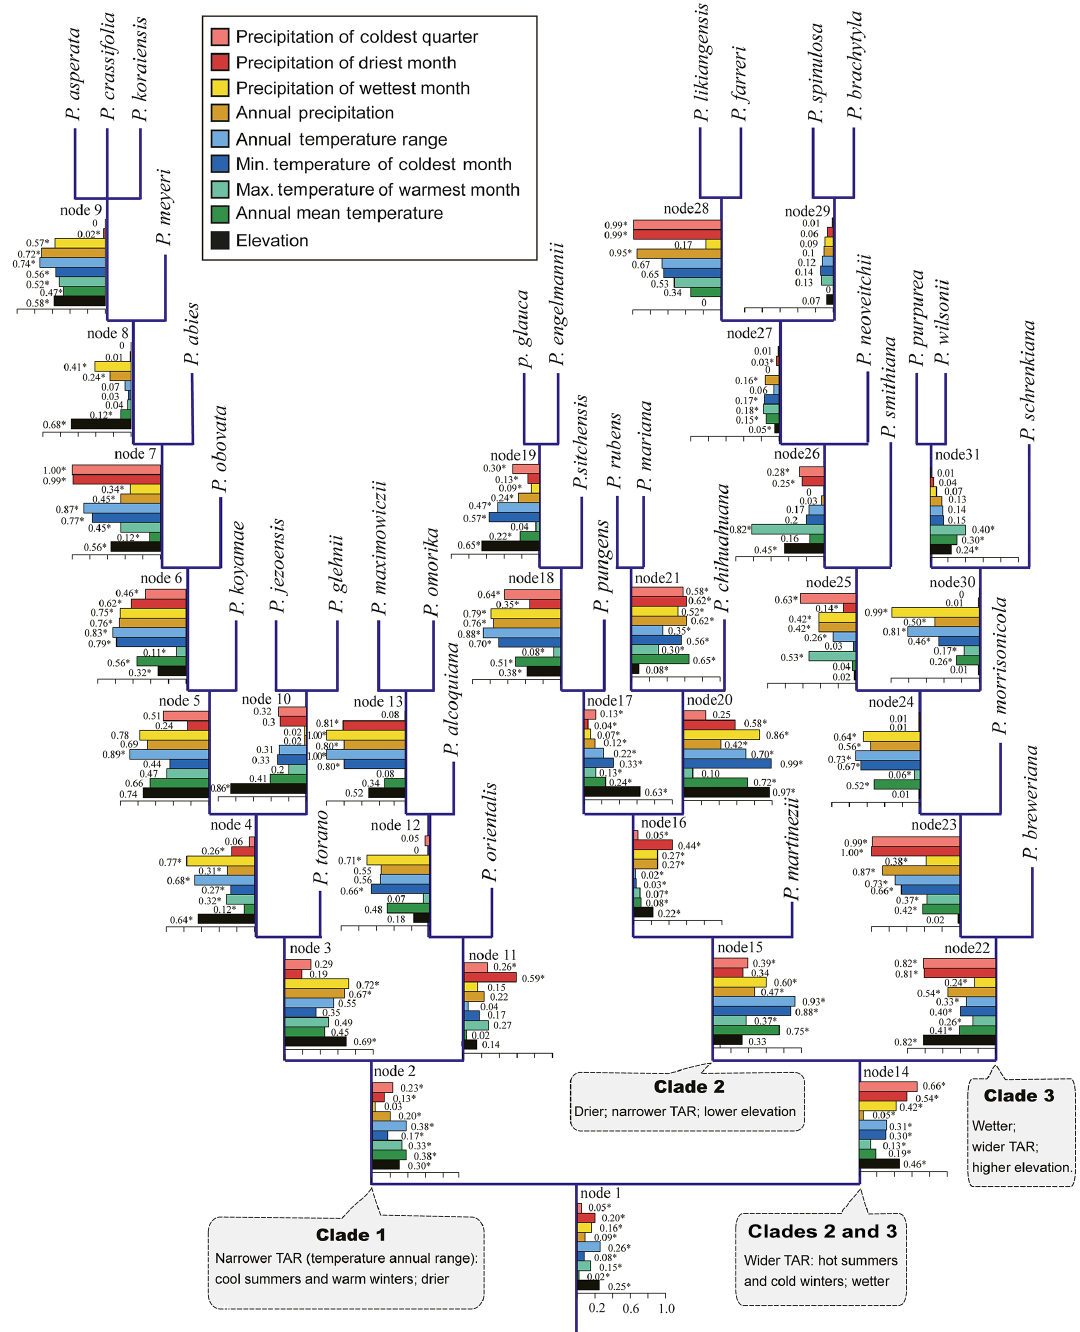
Figure 2. Divergence indices (scales range from 0 to 1) shown as histograms for elevation and for the eight climatic variables for each node of the phylogeny of Picea worldwide. ∗ Indicates a significant difference in ecological features after Bonferroni correction ( P < 0 .